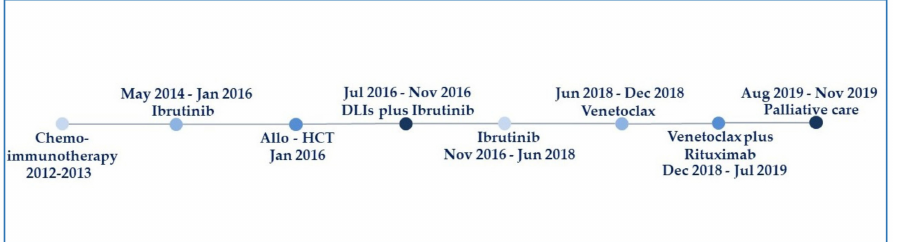
Figure 1. Treatment sequence (see text for further details). Allo-HCT, allogeneic stem cell transplant; DLIs, donor lymphocyte